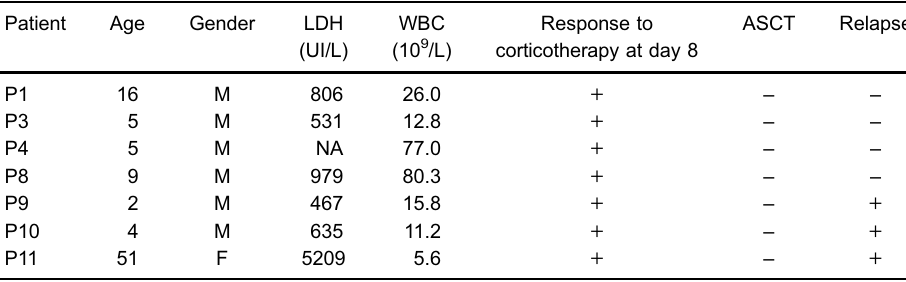
Table 2. Clinical and biological characteristics of B lineage acute lymphoblastic leukemia patients with minimal residual